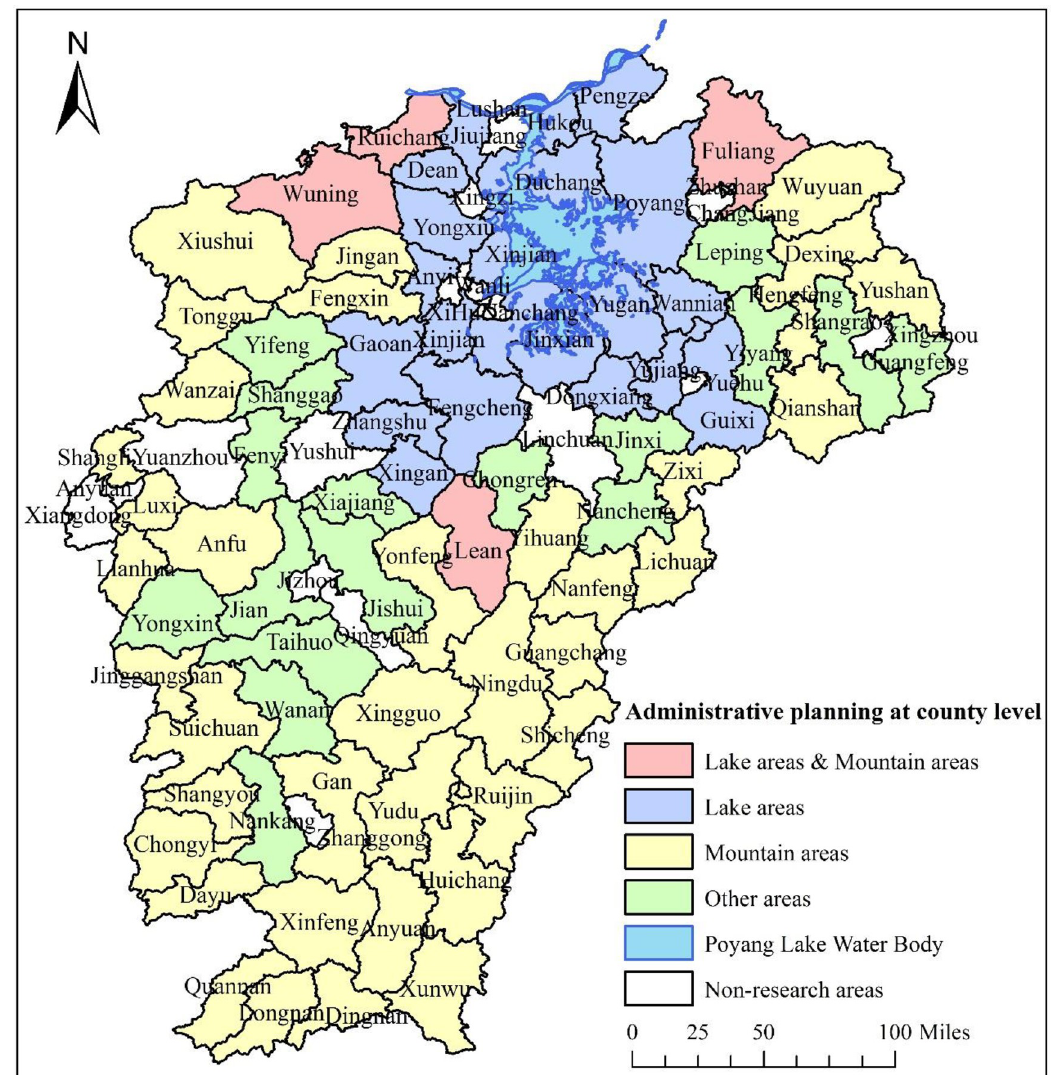
Fig 1. County administrative planning in Jiangxi